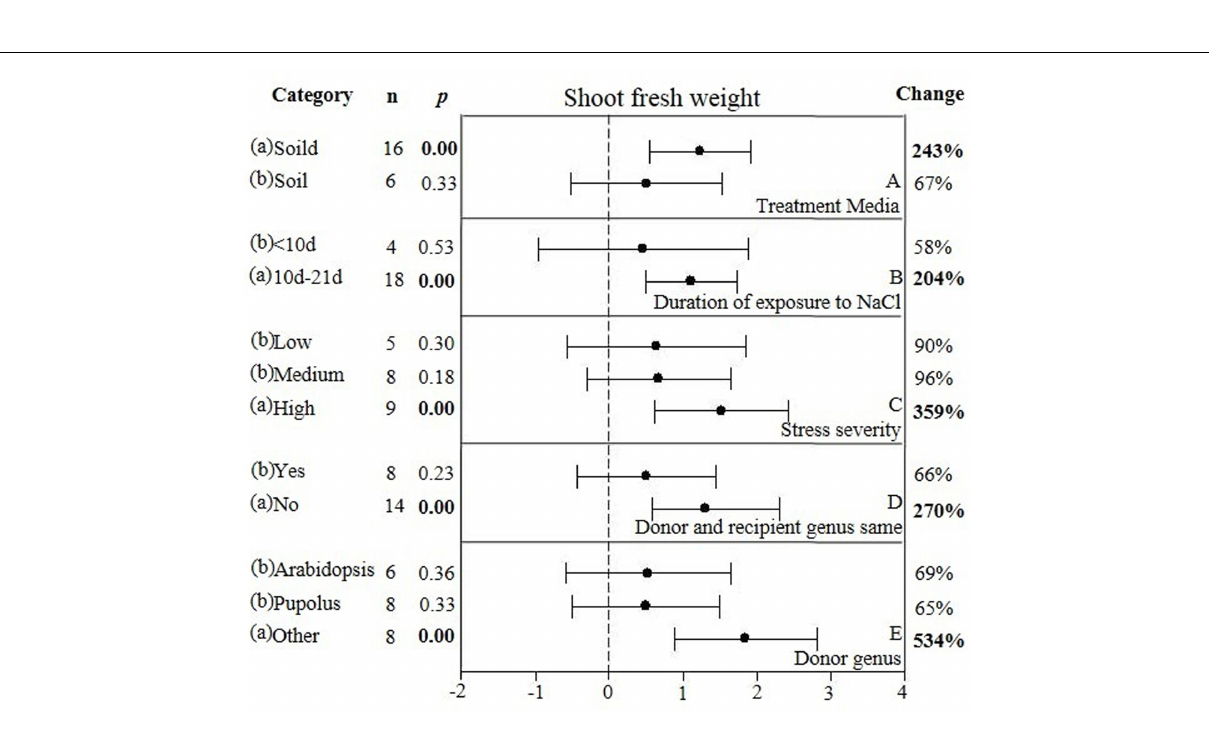
FIGURE 7 | Weighted summary effect sizes (ln R ) and 95% CIs showing how moderator variables affect the extent to which CBL transformation modifies shoot fresh weight. (A) Treatment media, (B) Duration of exposure to NaCl, (C) Stress severity, (D) Donor and recipient genus same, and (E) Donor genus. A p ≤ 0.05 indicates that the moderator level was significantly different than zero; n stands for the number of